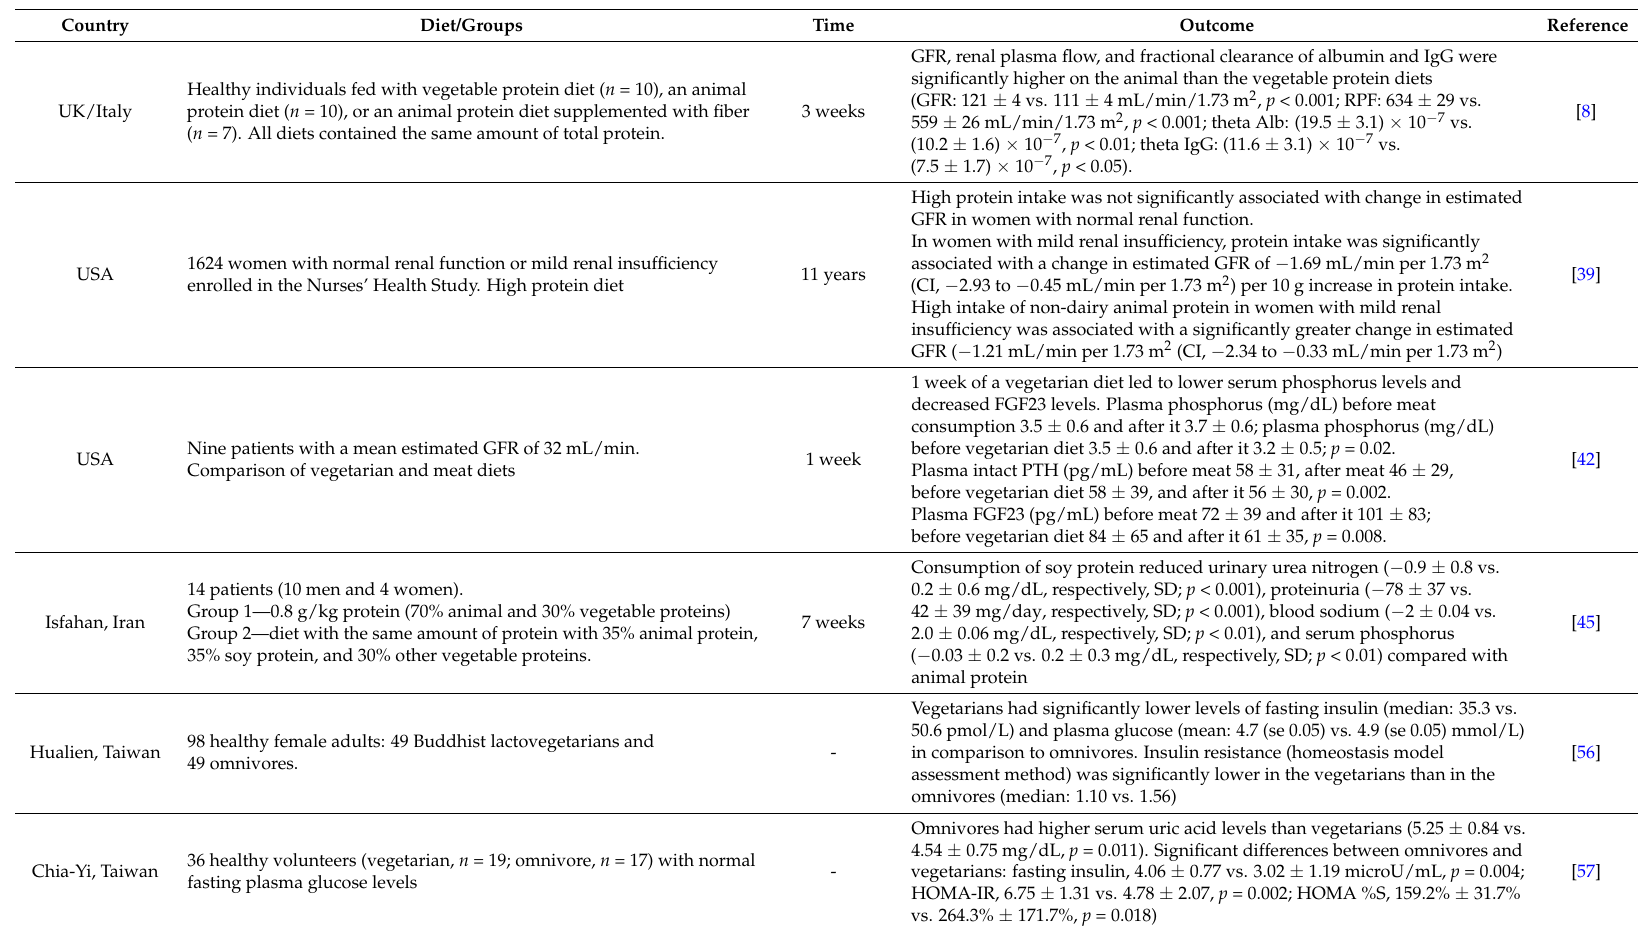
Table 2. The summary of results of described